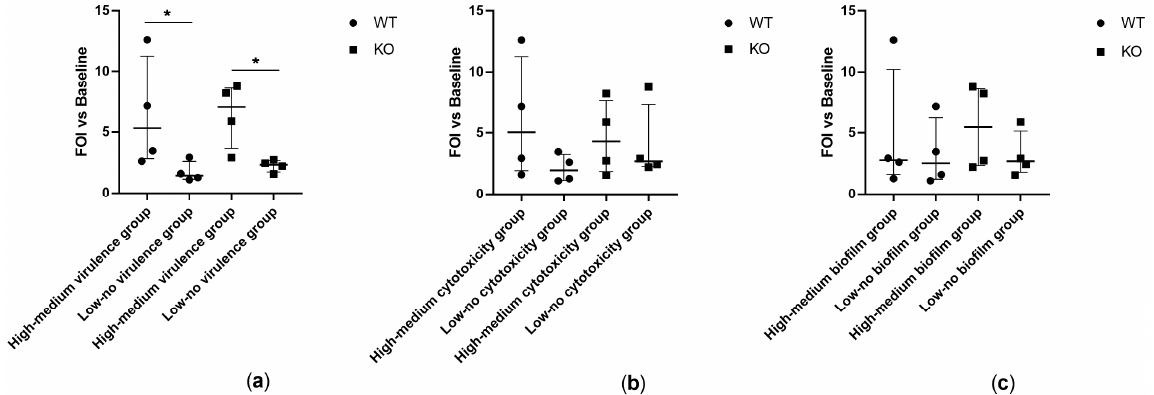
Figure 1. IL-8-dependent bioluminescence emitted by WT and KO mice at 24 h after intratracheal challenge with clinical isolates showing ( a ) high–medium vs. high-medium virulence in G. mellonella larvae, ( b ) high–medium vs. low–no cytotoxicity in human bronchial epithelial cells, and ( c ) high– medium vs. low–no biofilm formation. Photon emission is expressed as Folds of Induction (FOI) vs. baseline (before lung challenge). Each value represents the mean of four animals challenged with each isolate. The median ± interquartile range of 16 mice per group is shown. Statistical analysis was performed by Kruskal–Wallis test; * p < 0.05.